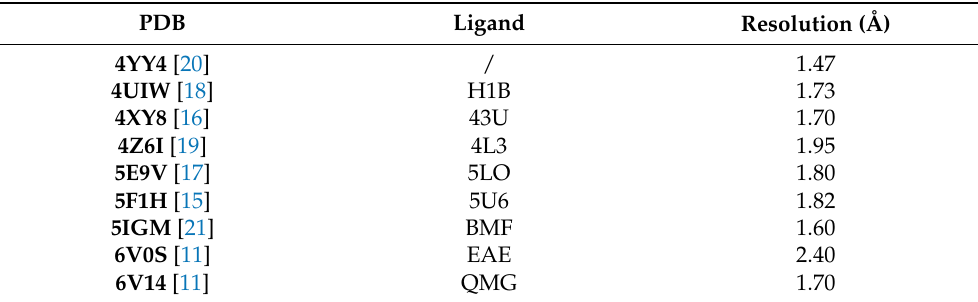
Table 9. Structural information of the ten crystal complexes used. References are reported in square brackets.